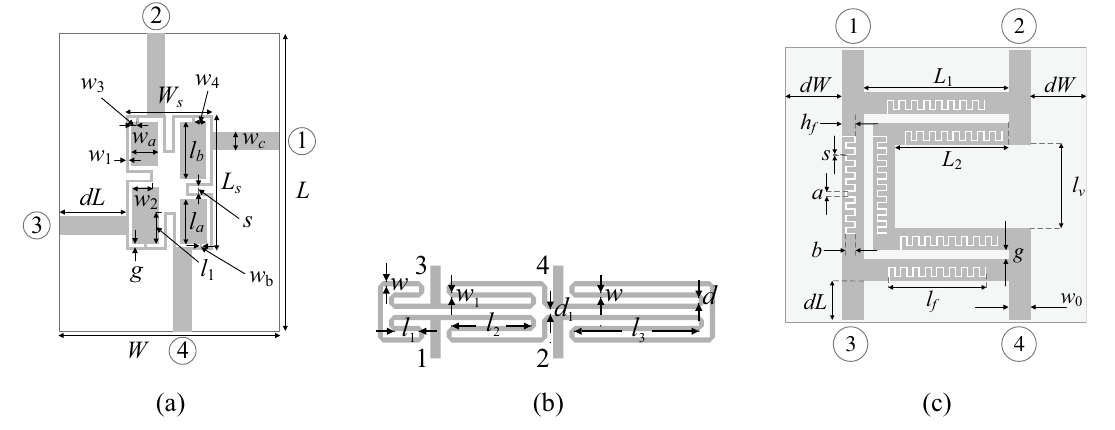
Figure 3. Passive microstrip components utilized for verification of the proposed optimization procedure: ( a ) compact branch-line coupler (Circuit I) 52 , ( b ) rat-race coupler with folder transmission lines (Circuit II) 53 , ( c ) rat-race coupler with defected microstrip structure (Circuit III) 54 .